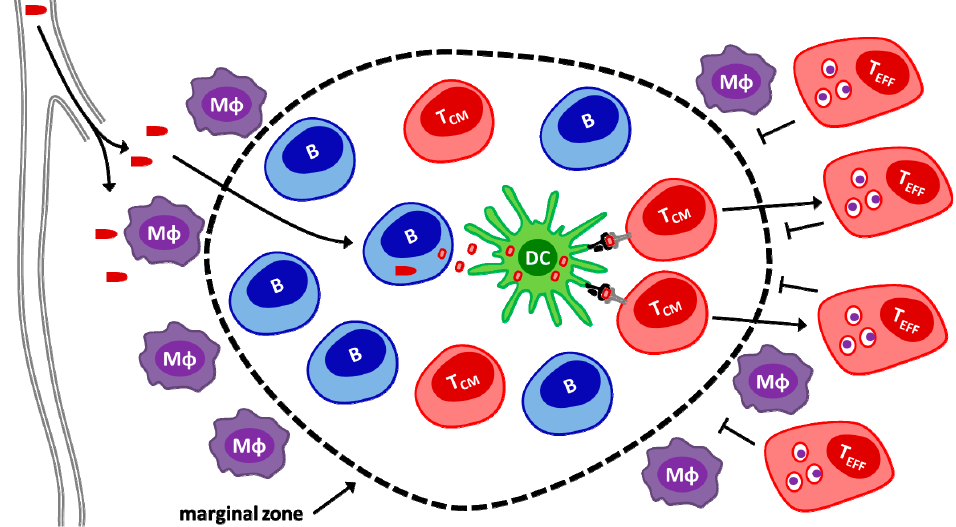
Figure 3. Rhabdovirus OVV boosting of T CM in the splenic follicle and the marginal zone as an anatomical barrier preventing T EFF recirculating back to the follicle. TAA-specific T CM cells induced by the priming vector reside in the splenic follicle which is maintained as an immunopriviliged site by the surrounding marginal zone and its resident marginal zone macrophages (M Φ ). When administered by intravenous injection, VSV traffics to the splenic follicle and infects follicular B cells. Infected B cells produce and release TAA encoded by the rhabdovirus which is taken up by neighbouring DCs and presented to T CM cells. Stimulated T CM cells are converted into T EFF and are excluded from the follicle by the marginal zone so that they cannot eliminate TAA carrying DCs.